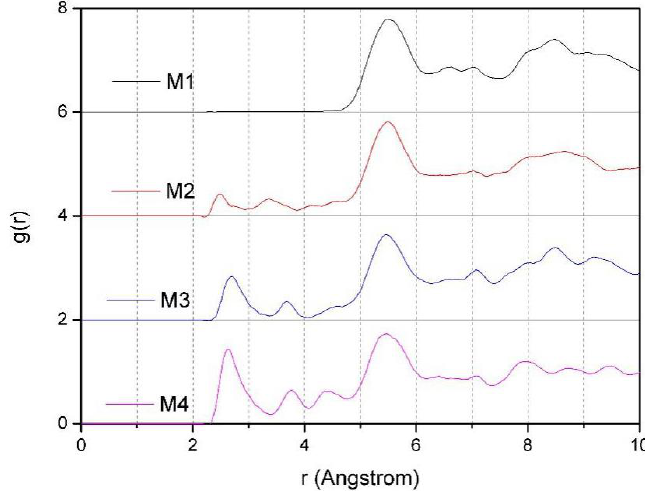
Figure 7. The RDF of Ca-O t of montmorillonites with different layer charge density.